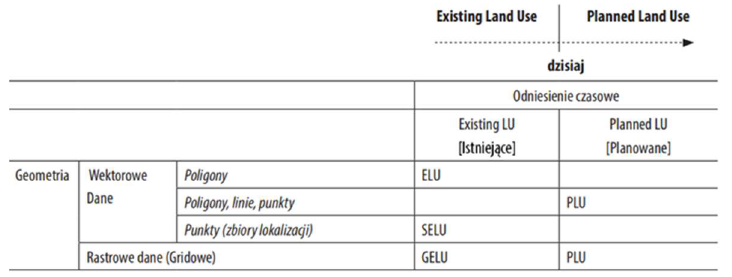
Figure 12. ELU and PLU with the corresponding application diagrams. Resources: Stelmach-Fita [7].